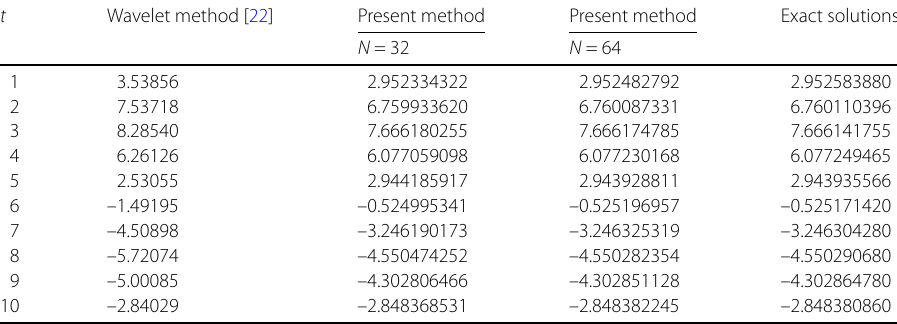
Table 2 Comparison of the numerical results of the wavelet and the present method for Example 9.2